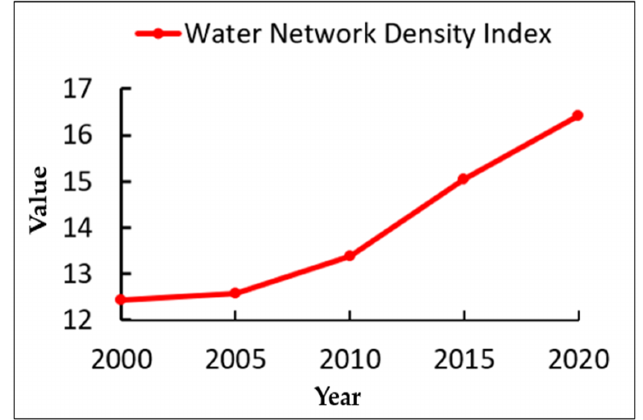
Figure 11. The change of water density index in Rangtang County.